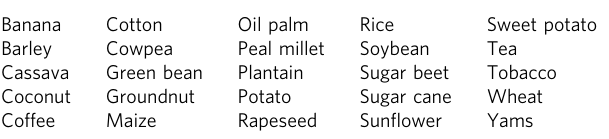
Table 2 Crops included in the